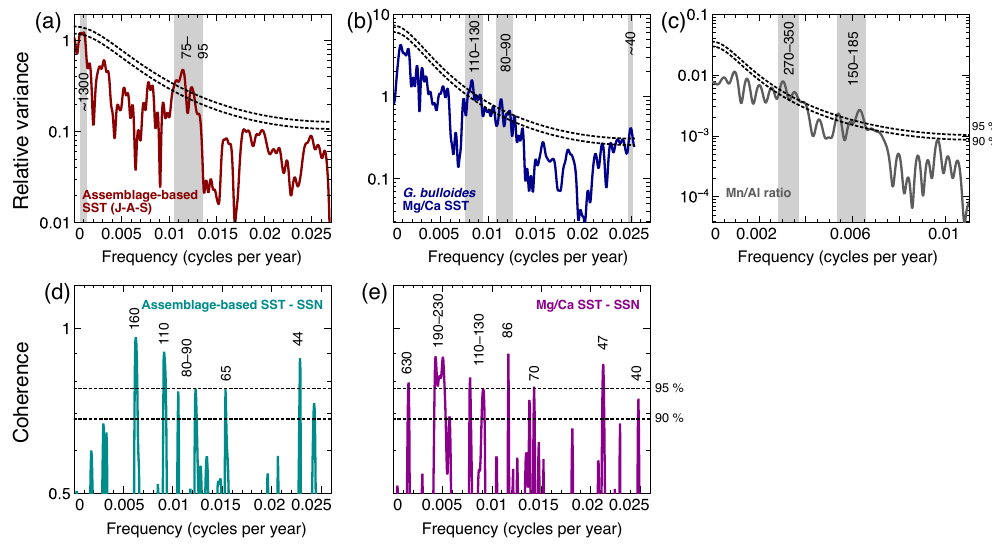
Figure 8. Results of the MTM spectral analysis show the frequency distribution and identified significant periodicities of the (a) assemblage- based SST record, (b) the SST record using Mg / Ca ratios of G. bulloides and (c) the Mn / Al ratio as a proxy for OMZ conditions. Black lines indicate 90 and 95% significance levels against red noise. Cross-spectral coherence of both SST records (d, e) with the record of sunspot numbers (Solanki et al., 2004) indicates that both records significantly co-vary on a wide range of frequencies. All time series were trend-removed prior to the